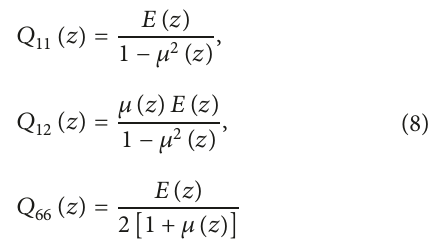
Figure 2: Variation of volume fraction 𝑉𝑐 through the thickness for different values of power-law